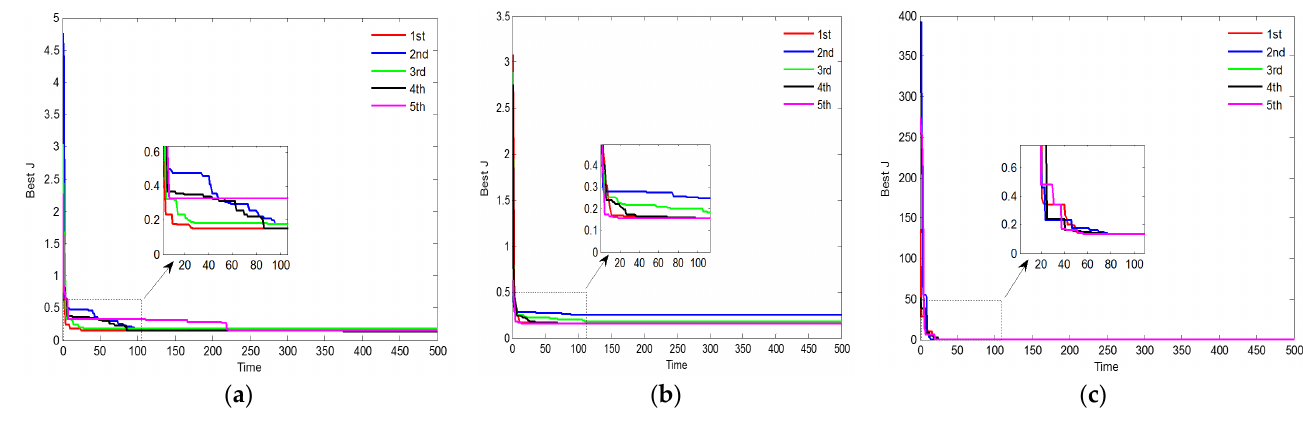
( b ) Figure 4. The experimental test system: ( a ) System connection diagram; ( b ) GMA actuator.